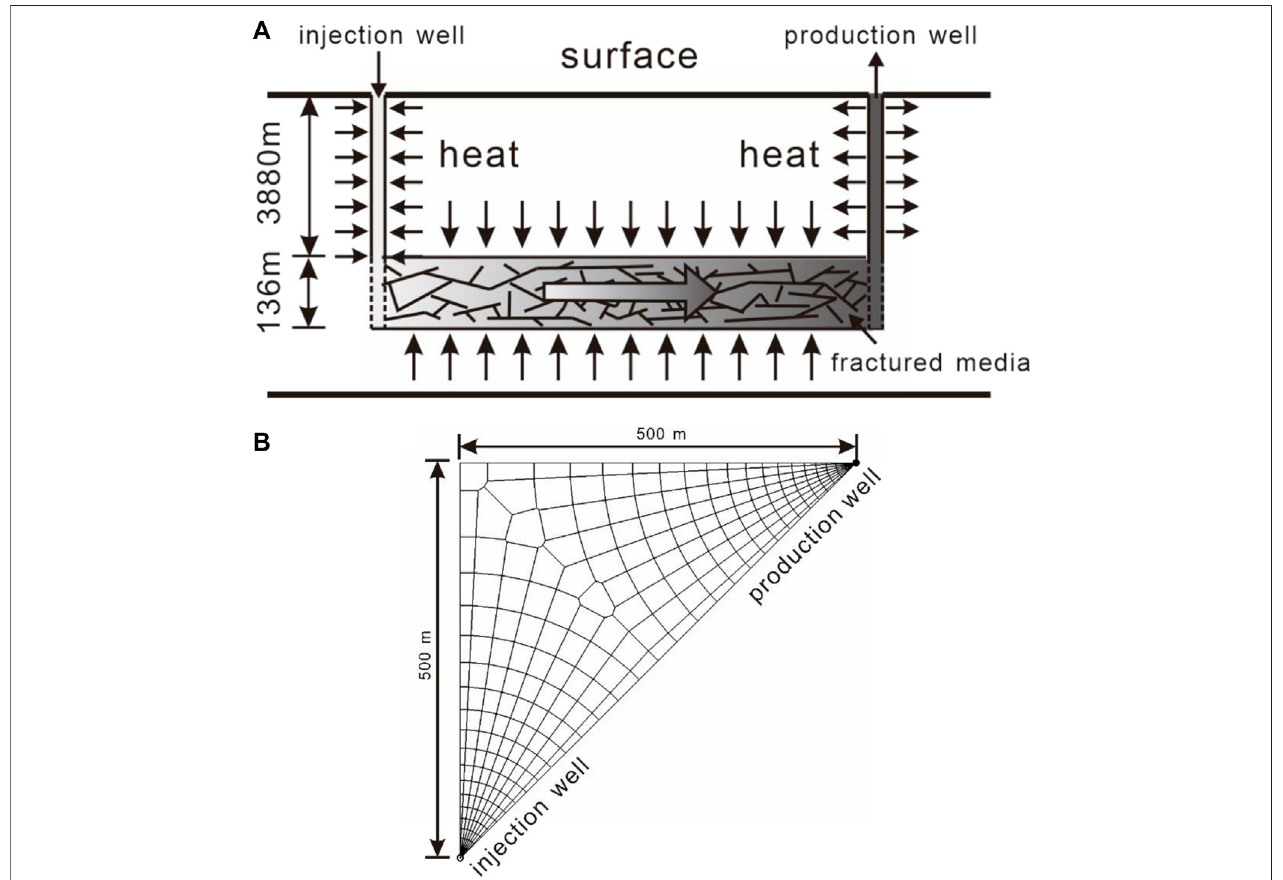
FIGURE 2 | (A) Conceptual model for the heat extraction from EGS and (B) grid partition of the reservoir.